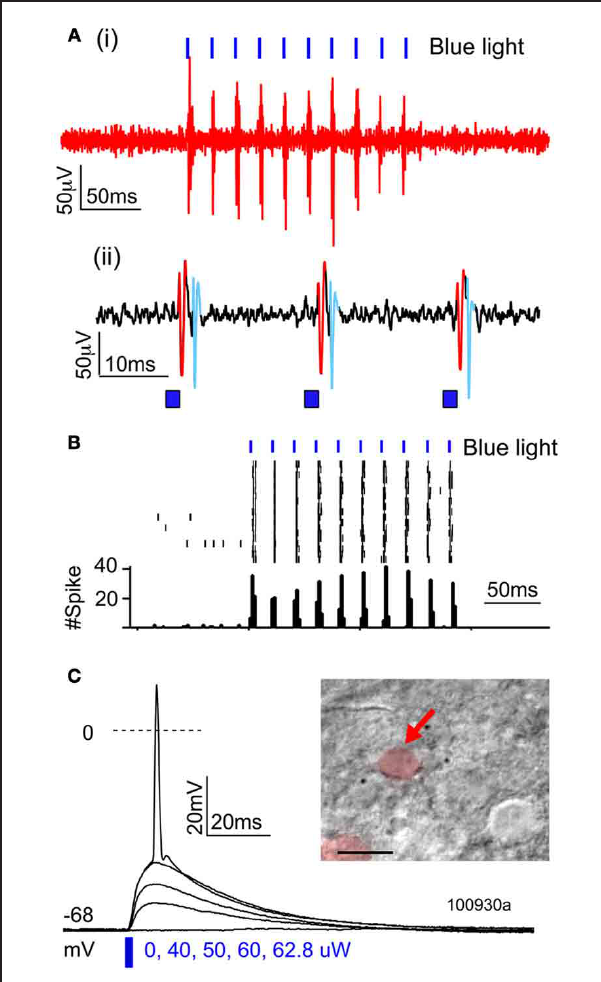
FIGURE 2 | Functional activation of ChR2 in vivo and in vitro . (A,B) Extracellular multiunit recording in L2/3 in vivo (200–300 um depth) in a urethane-anesthetized rat (P100). (A) Raw voltage recording at two time scales. (B) Spikes elicited by trains of 2-ms light pulses (473nm, 20mW, 50Hz, 10s intertrial interval). (C) Light-evoked potentials recorded from a ChR2-expressing L2/3 neuron in a brain slice, in response to increasing light intensity (2-ms light pulse).